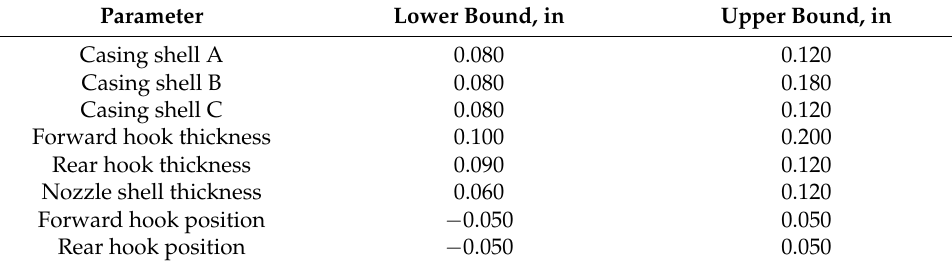
Table 2. Geometrical thickness and position parameters.